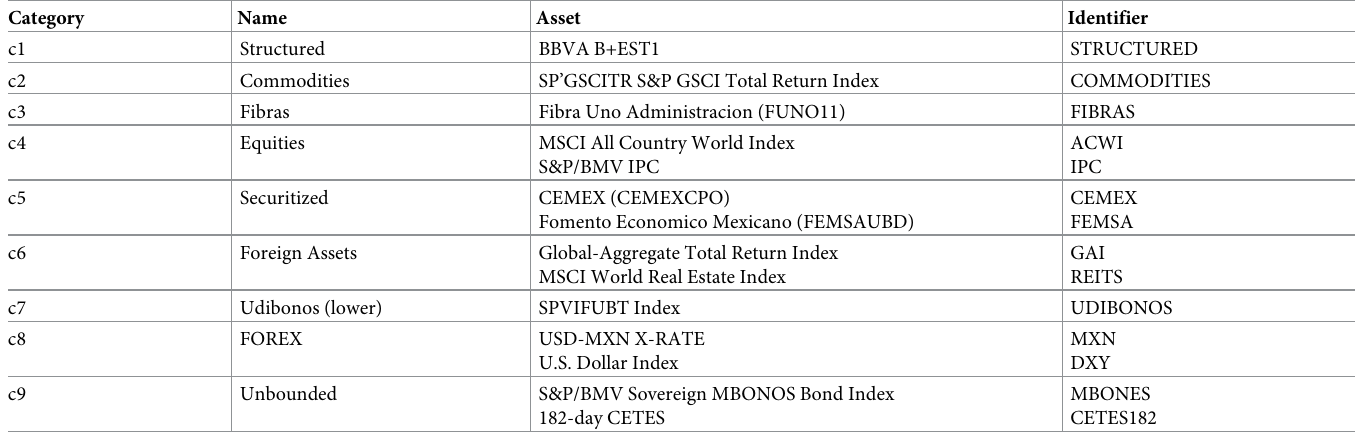
The first column enumerates the asset’s category. The second column lists the names of categories. The third column describes the full name of each asset. The fourth column represents the assets by an